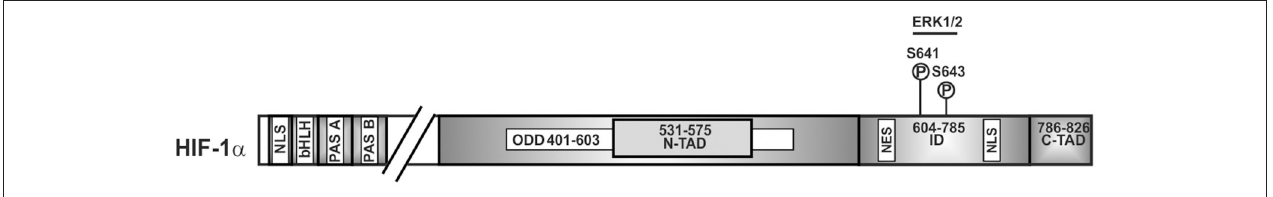
FIGURE 3 | Kinases involved in nuclear accumulation of HIF-1 α . Scheme of HIF-1 α and its domain organization with specific amino acid residues phosphorylation of which affects nuclear translocation. ERK2, extracellular regulated kinase2; bHLH, basic helix loop helix domain; NLS, nuclear localization sequence; PAS, Per-ARNT-Sim domain; N-TAD, N-terminal transactivation domain; ID, inhibitory domain; C-TAD, C-terminal transactivation domain; numbers indicate the amino acid residue range of the respective